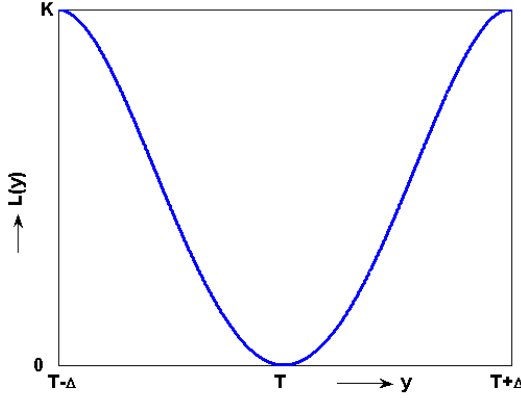
Figure 4. Typical form of the proposed symmetric PLF